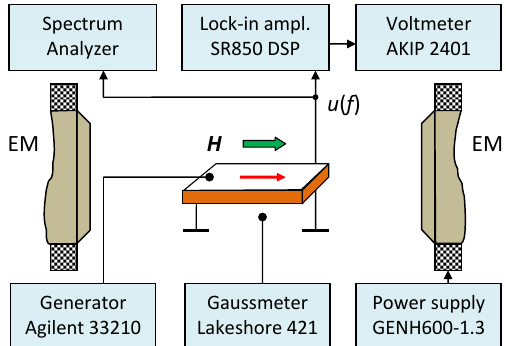
Figure 8. The block diagram of the experimental set-up for the ME effect investigation under coil-free excitation.